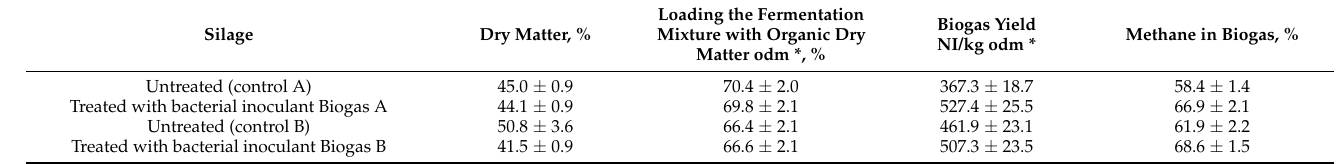
Table 3. Biogas yield and biogas purity produced from grass silage: untreated (control) and treated with the bacterial inoculant Biogas A consisted of L. buchneri KKP 2047p and L. diolivorans KKP 2057p or bacterial inoculant Biogas B consisted of L. buchneri KKP 2047p and P. acidilactici KKP 2065p. There was showed a standard deviation for each measurement (after the symbol “ ±